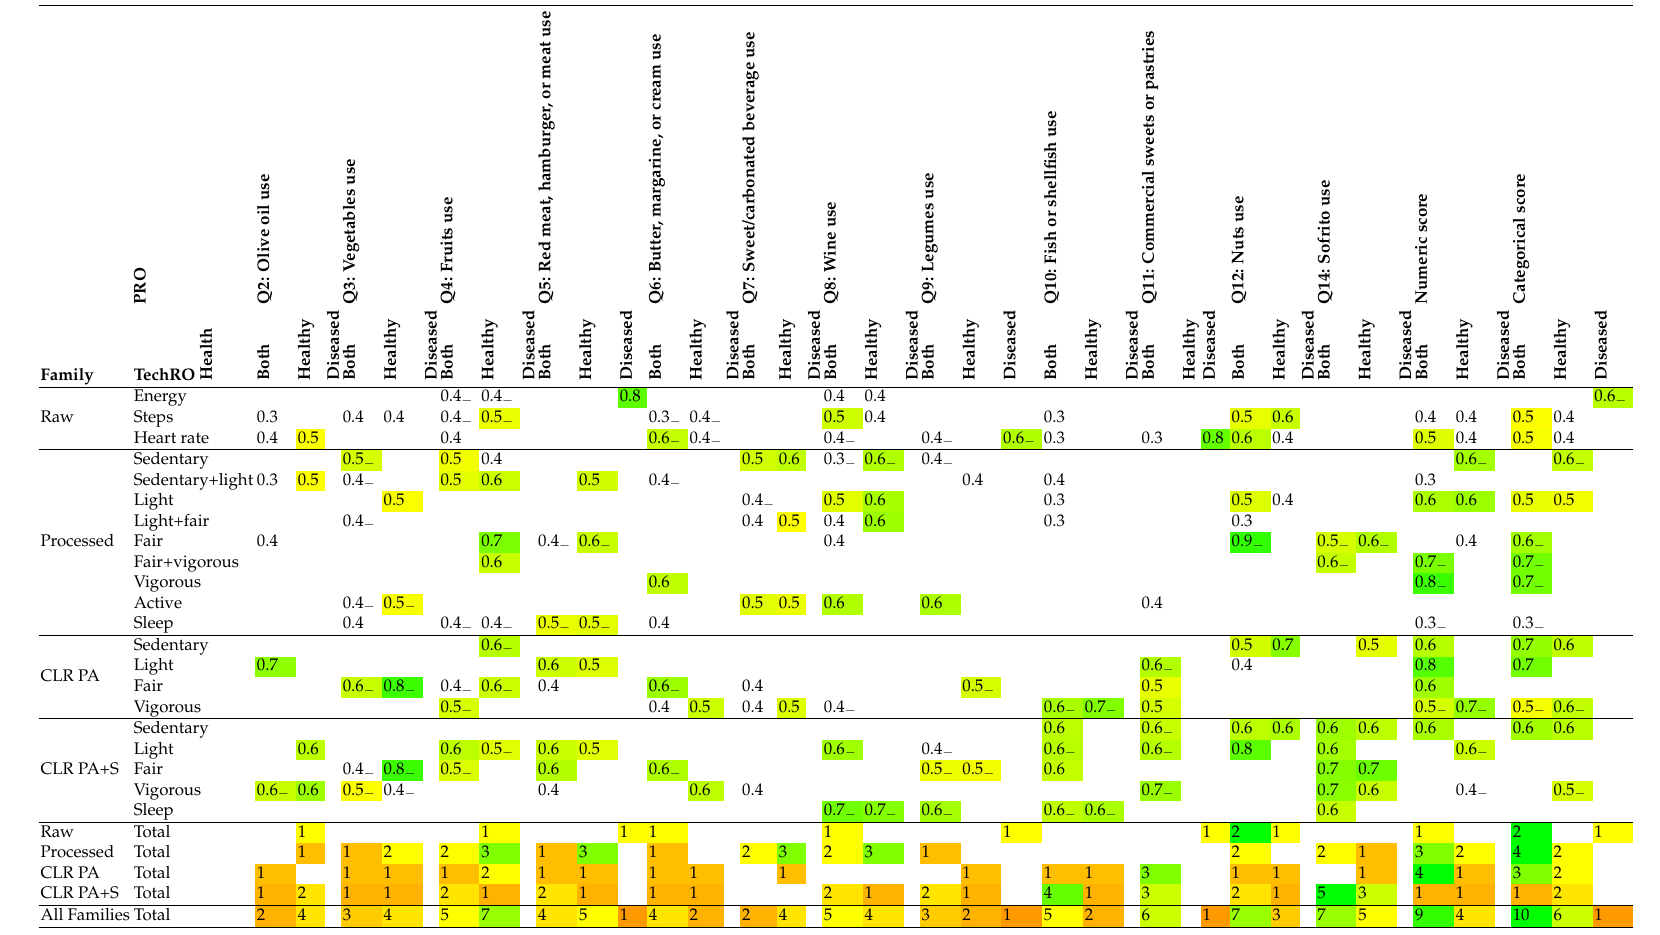
Table A16. Correlation coefficient (Spearman r S ) between TechROs from Fitbit (rows) and PROs of Mediterranean Nutrition on the PREDIMED scale (columns).